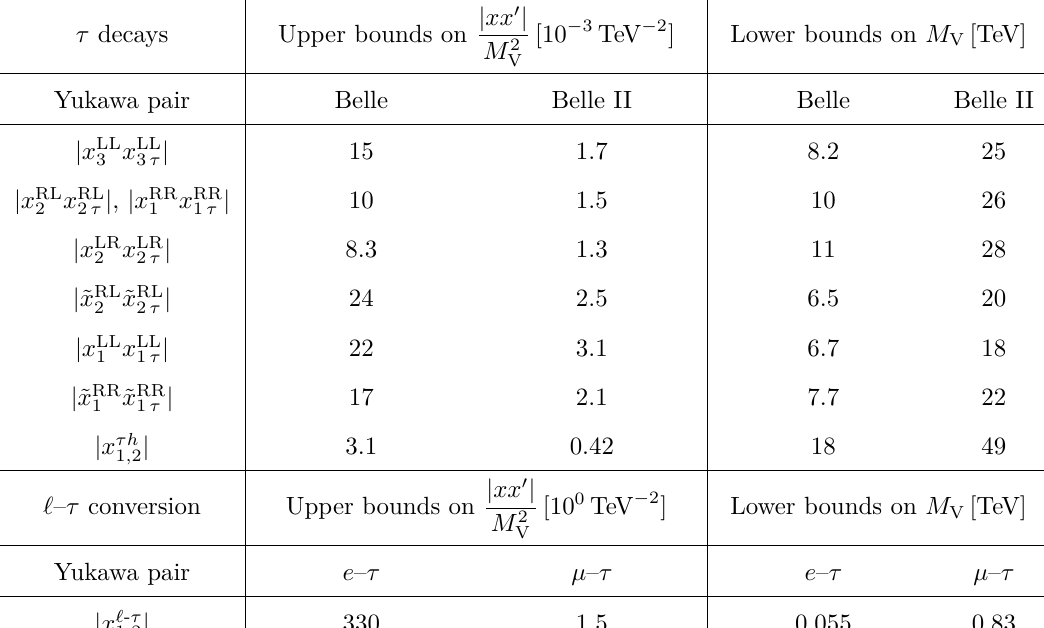
Table 6. Obtained bounds for the vector leptoquark case from the bounds determined in ref. [1]. In the left-hand part of the table, we present upper bounds on the ratio | xx 0 | /M 2 correspond to upper bounds on the Yukawa pairs | xx 0 | , assuming M are lower bounds on the probed energy scale of the scalar leptoquarks mediating CLFV phenomena ( Λ = M ), considering | xx 0 | ≈ 1 . Again, the strongest bounds found are shown, stemming CLFV V mostly from the τ decay constraints, except for the last row related solely to ‘ – τ conversion. The values are given at the 99.8 % confidence